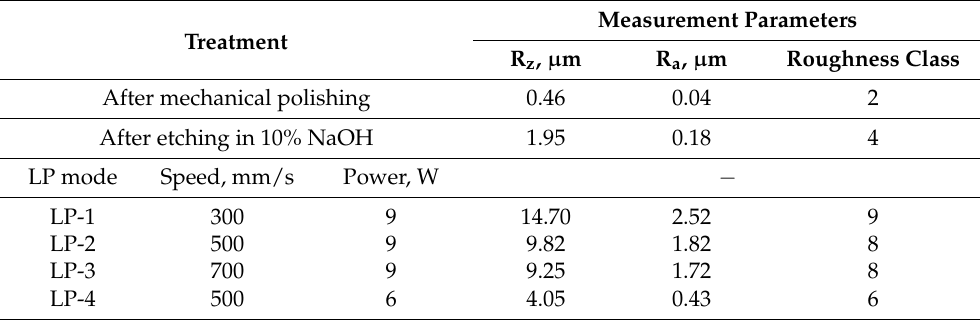
Table 1. Results of profilometric measurements of the surface of alloy 6063 samples after mechanical polishing, etching in 10% NaOH solution and subjected to LP. Measurement error of profilometer is 2%. Measurement Parameters Treatment R z , µ m R a , µ m Roughness Class After mechanical polishing 0.46 0.04 2 After etching in 10% NaOH 1.95 0.18 4 LP mode Speed, mm/s Power, W − LP-1 300